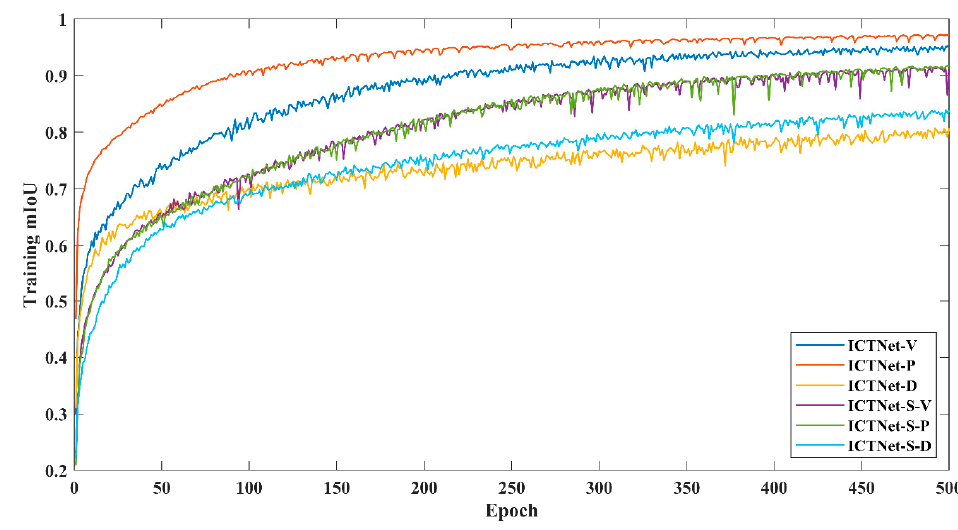
Figure A2. Training mIoU of ablation study of DFA.